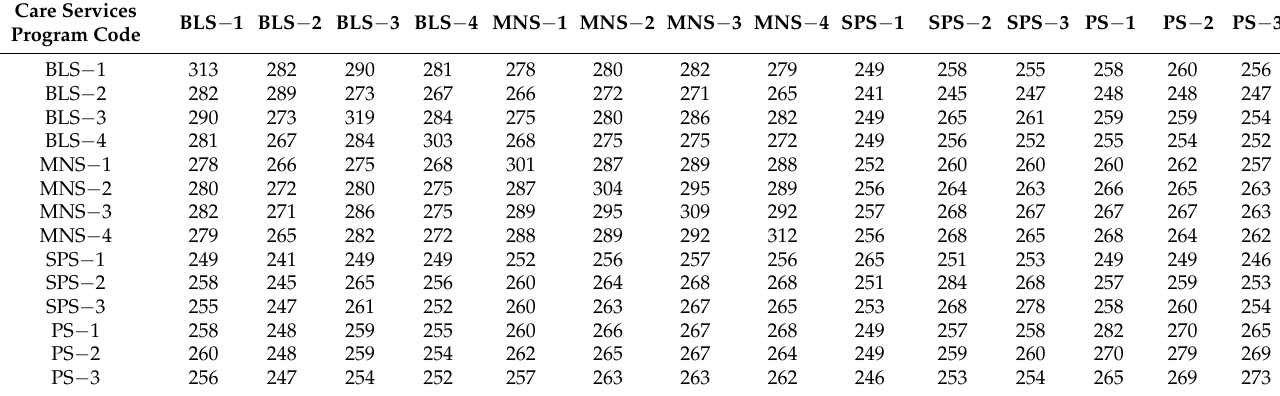
Table 6. Incident matrix between the inadequately met care needs of the disabled